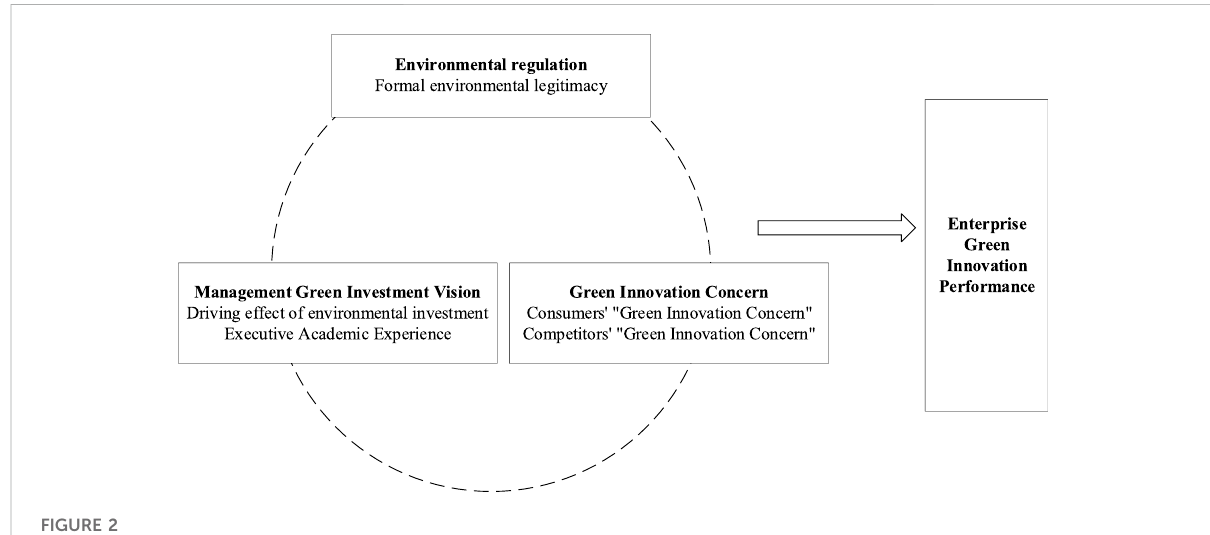
FIGURE 2 Analytical framework of factors driving enterprise green innovation